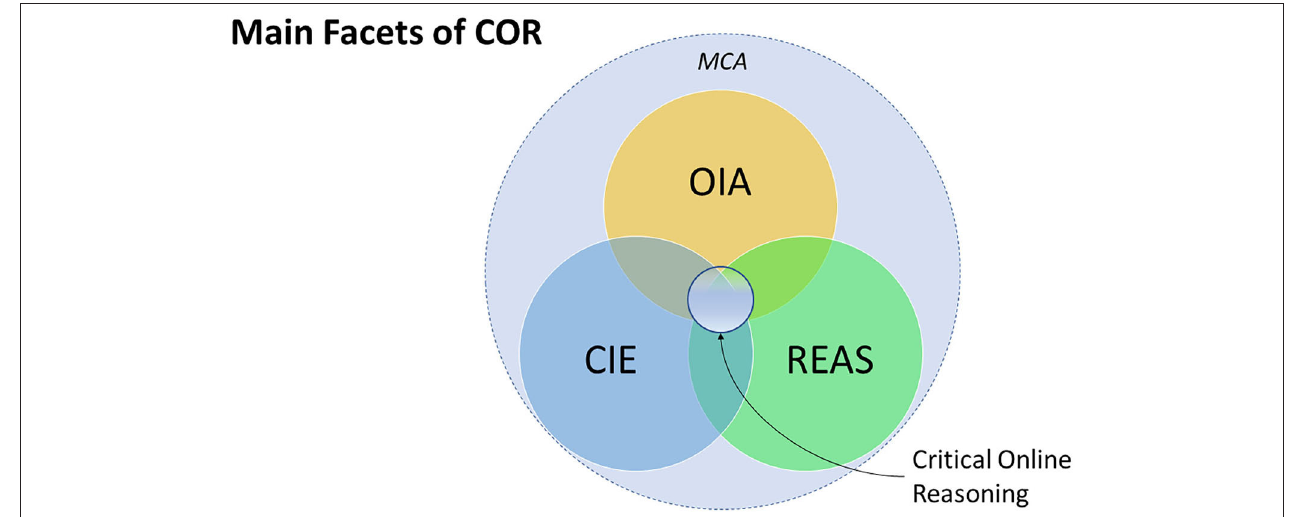
FIGURE 1 | The COR construct with its main facets: MCA, metacognitive activation; OIA, online information acquisition; CIE, critical information evaluation; REAS, reasoning with evidence, argumentation and